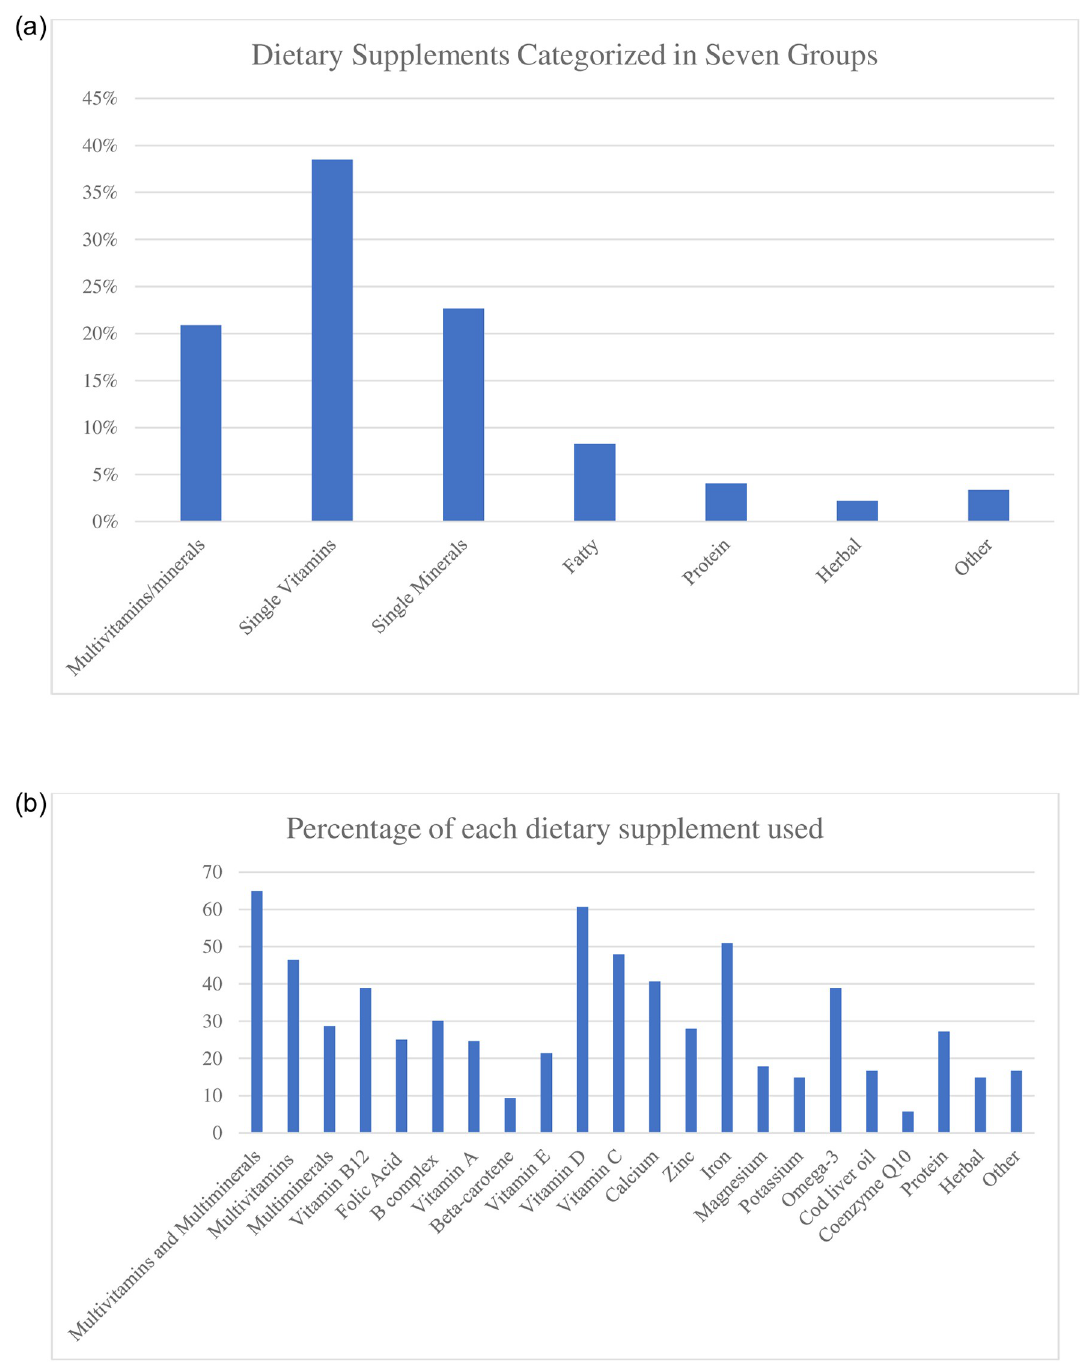
Fig 1. a. The percentage of participants using dietary supplement, categorized in seven groups (n = 275). b. The percentage of participants using each dietary supplement (n = 275).